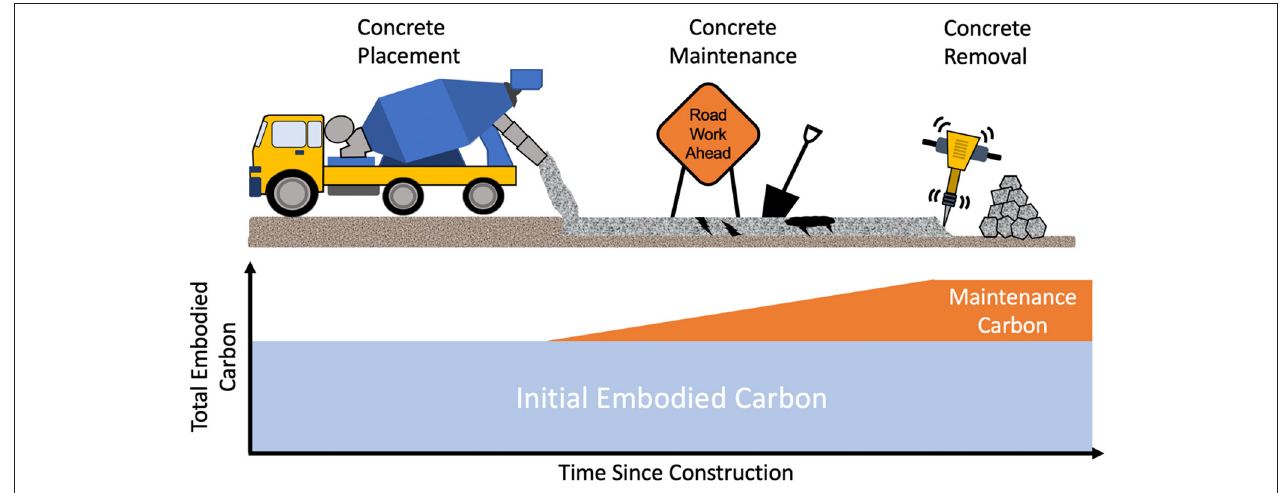
FIGURE 5 | Conceptual illustration of total embodied carbon in traditional